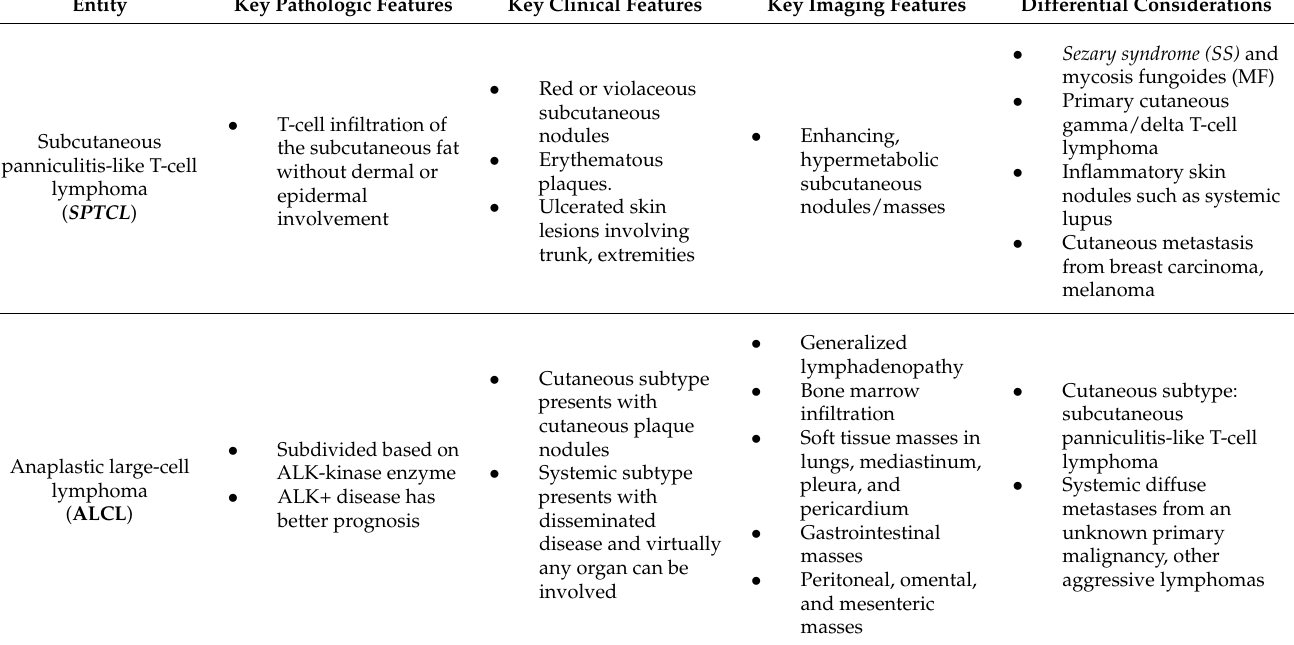
Table 4. Key clinical, imaging, and pathologic features of some mature T-cell lymphomas (MTCLs).